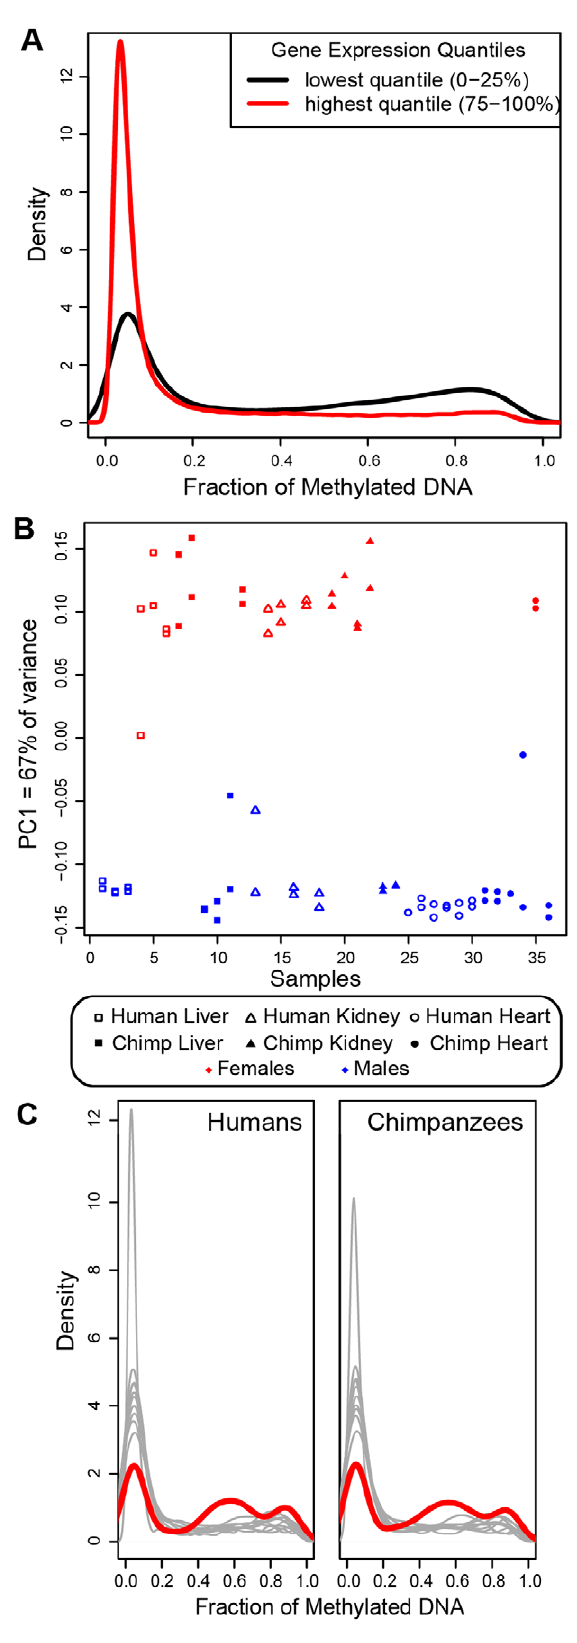
Figure 1. Genome-wide methylation patterns across all sam- ples. (A) Probability density functions (y-axis) of estimated promoter methylation levels (plotted as b -values on the x-axis) for genes whose